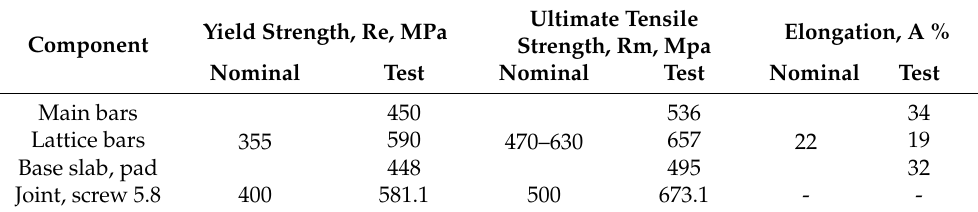
Table 2. Material test results.